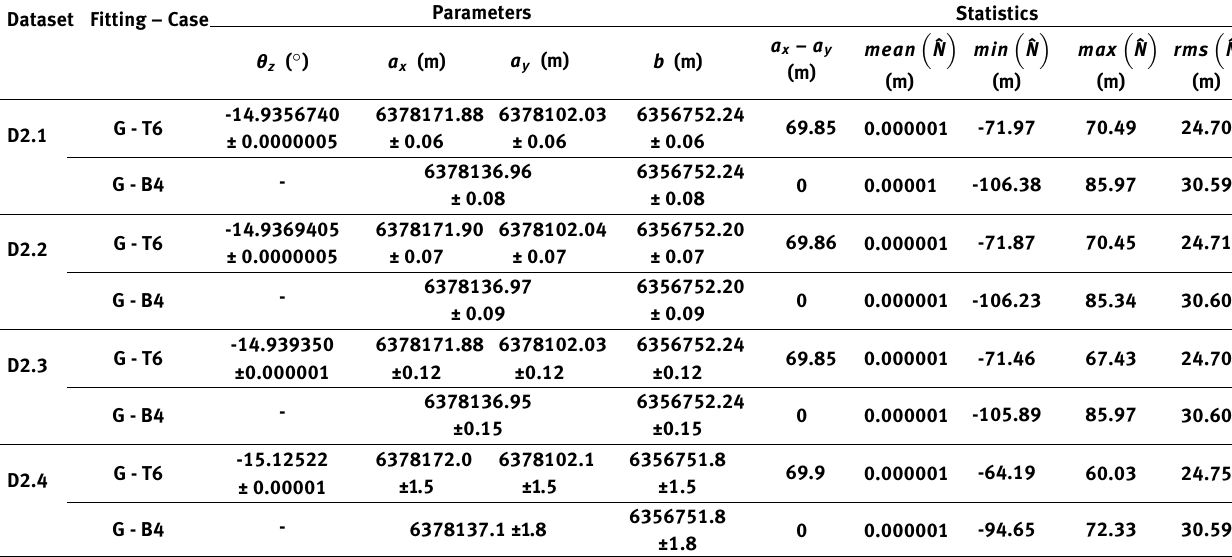
Table 7. Resulting values of the parameters and statistics of fitting for the geoid model EGM2008